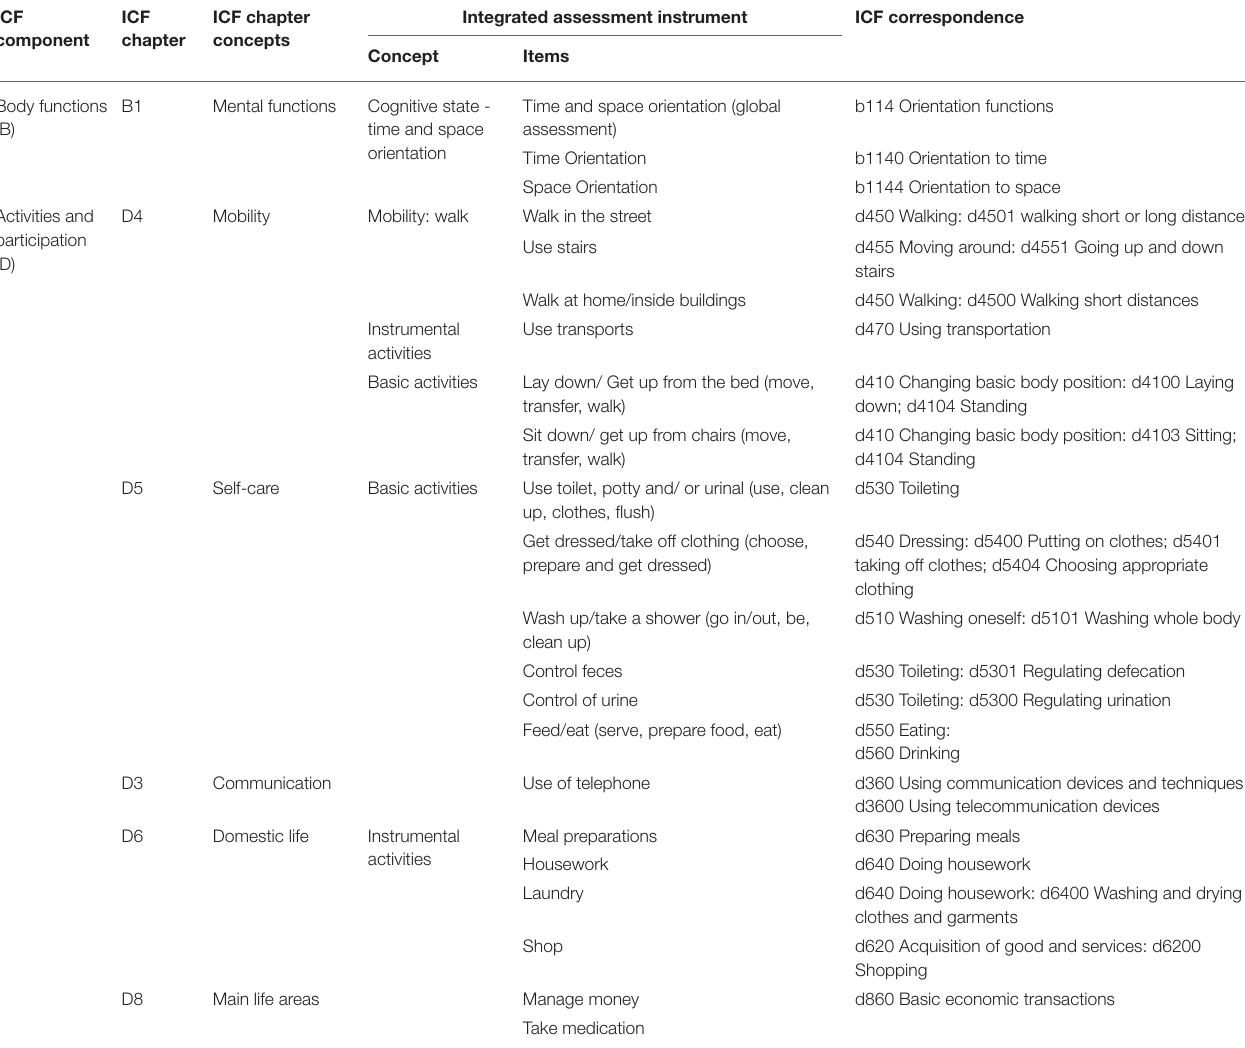
TABLE 3 | Instrument’s items x aligned with the corresponding ICF ( International Classification of Functioning, Disability and Health ) concepts. ICF